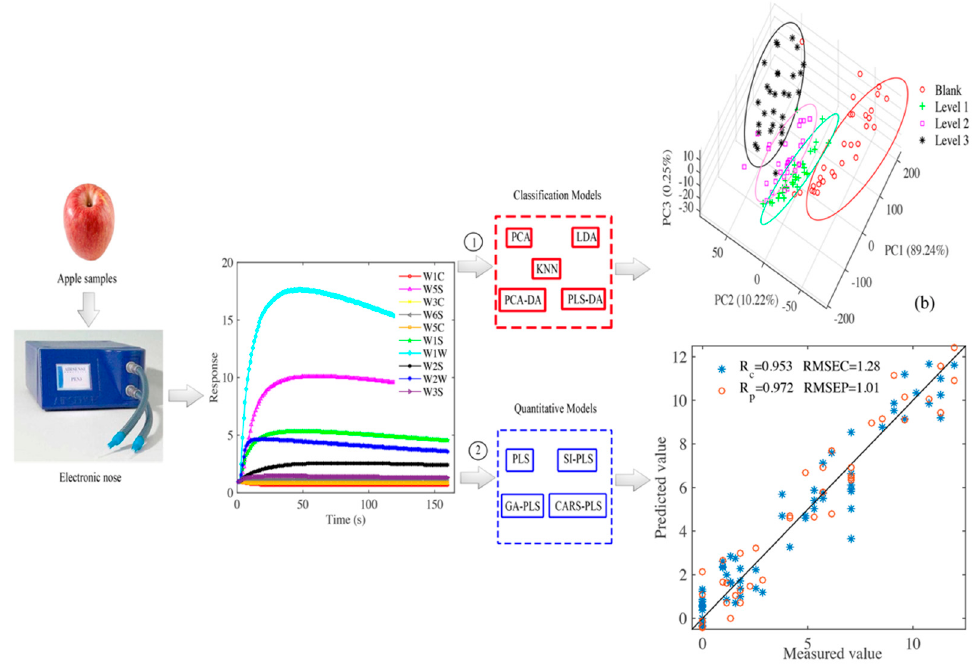
Figure 1. Schematic procedures of classification and prediction of defects of Penicillium expansum in apples by electronic nose combined with chemometrics.